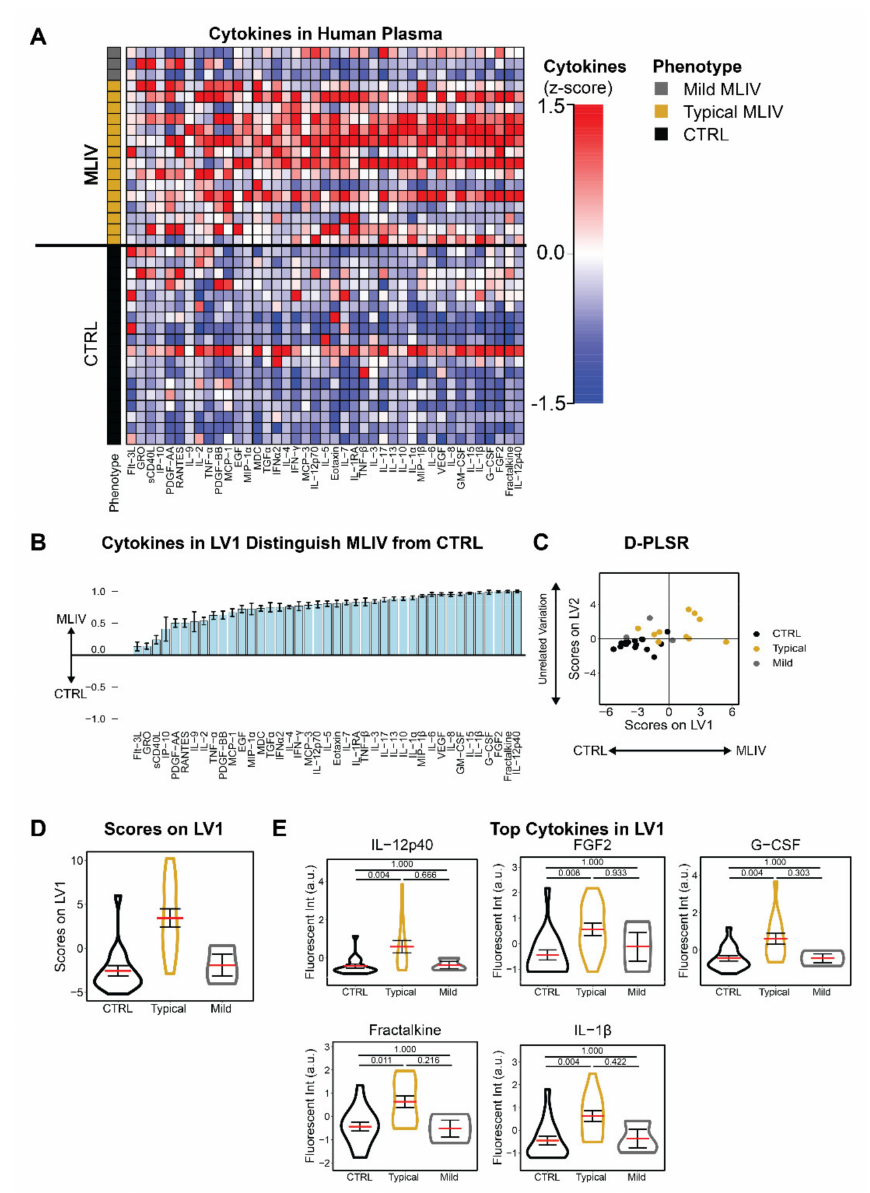
Figure 1. Plasma cytokines are increased in MLIV patients compared to familial controls. ( A ) Panel of 41 cytokines measured from plasma samples using a multiplexed immunoassay. Each column is z-scored, N = 18 CTRL, 18 MLIV (15 typical and 3 mild). ( B ) A discriminant partial least squares regression (D-PLSR) was used to simultaneously regress all measured cytokines against disease group (CTRL, MLIV). The D-PLSR identified a profile of cytokines, called a latent variable 1 (LV1), that separated MLIV cases (positive) from CTRL cases (negative) (mean ± SD in a leave-K-out cross-validation (LKOCV) with K = 5). ( C ) LV1 separated MLIV cases to the right and both CTRL and mild cases to the left. (D) Violin plots showing scoring of samples in ( C ) in each group (mean ± SEM) along LV1. N = 18 CTRL, 18 MLIV (15 typical and 3 mild). ( E ) Violin plots showing